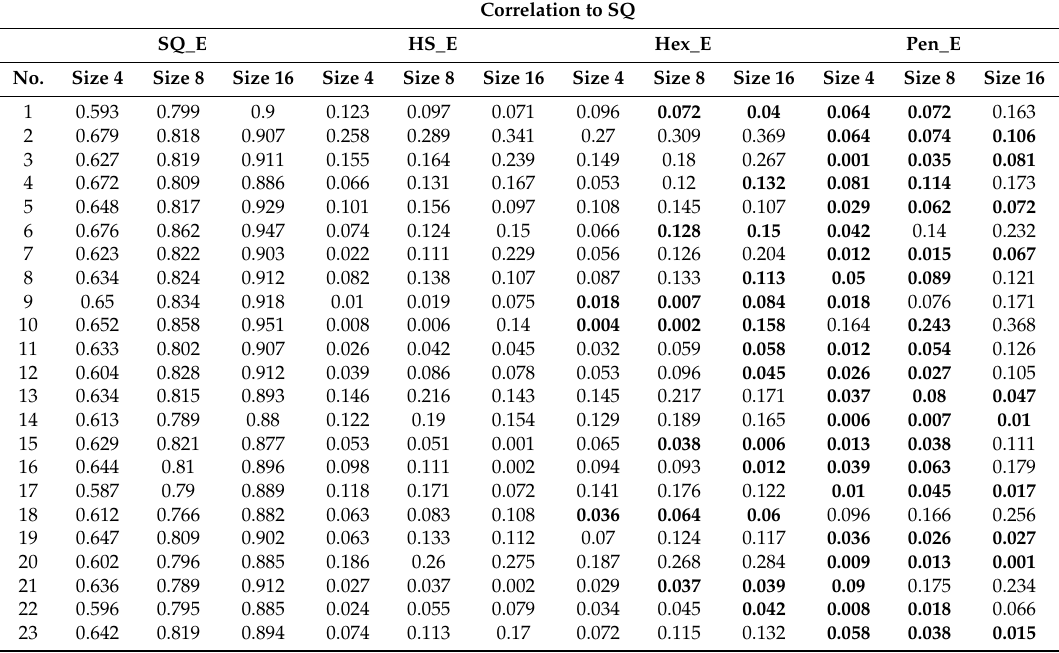
Table 3. The correlation between the results of HoG for SQ images and the other four types of images in respect to block